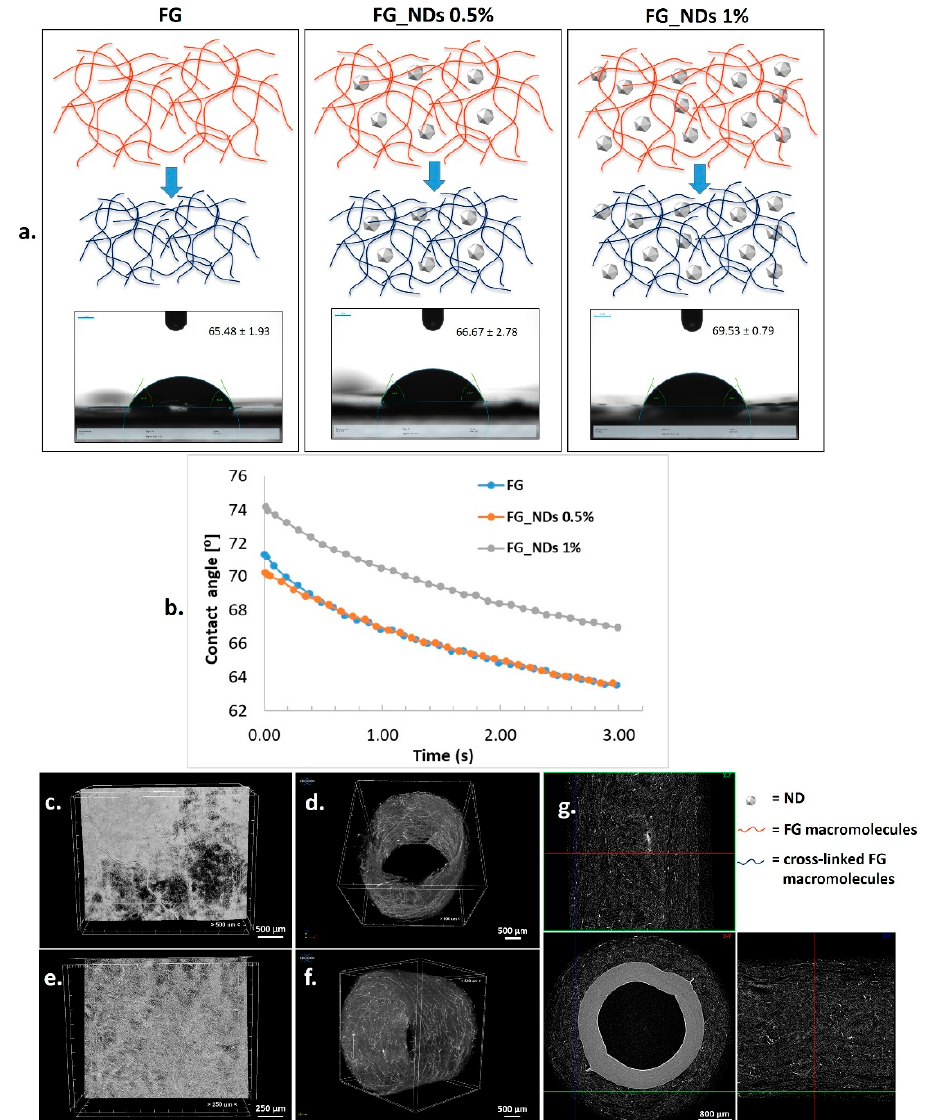
Figure 2. ( a ) Schematic representation of nanodiamond particles (NDs) nanocomposite synthesis